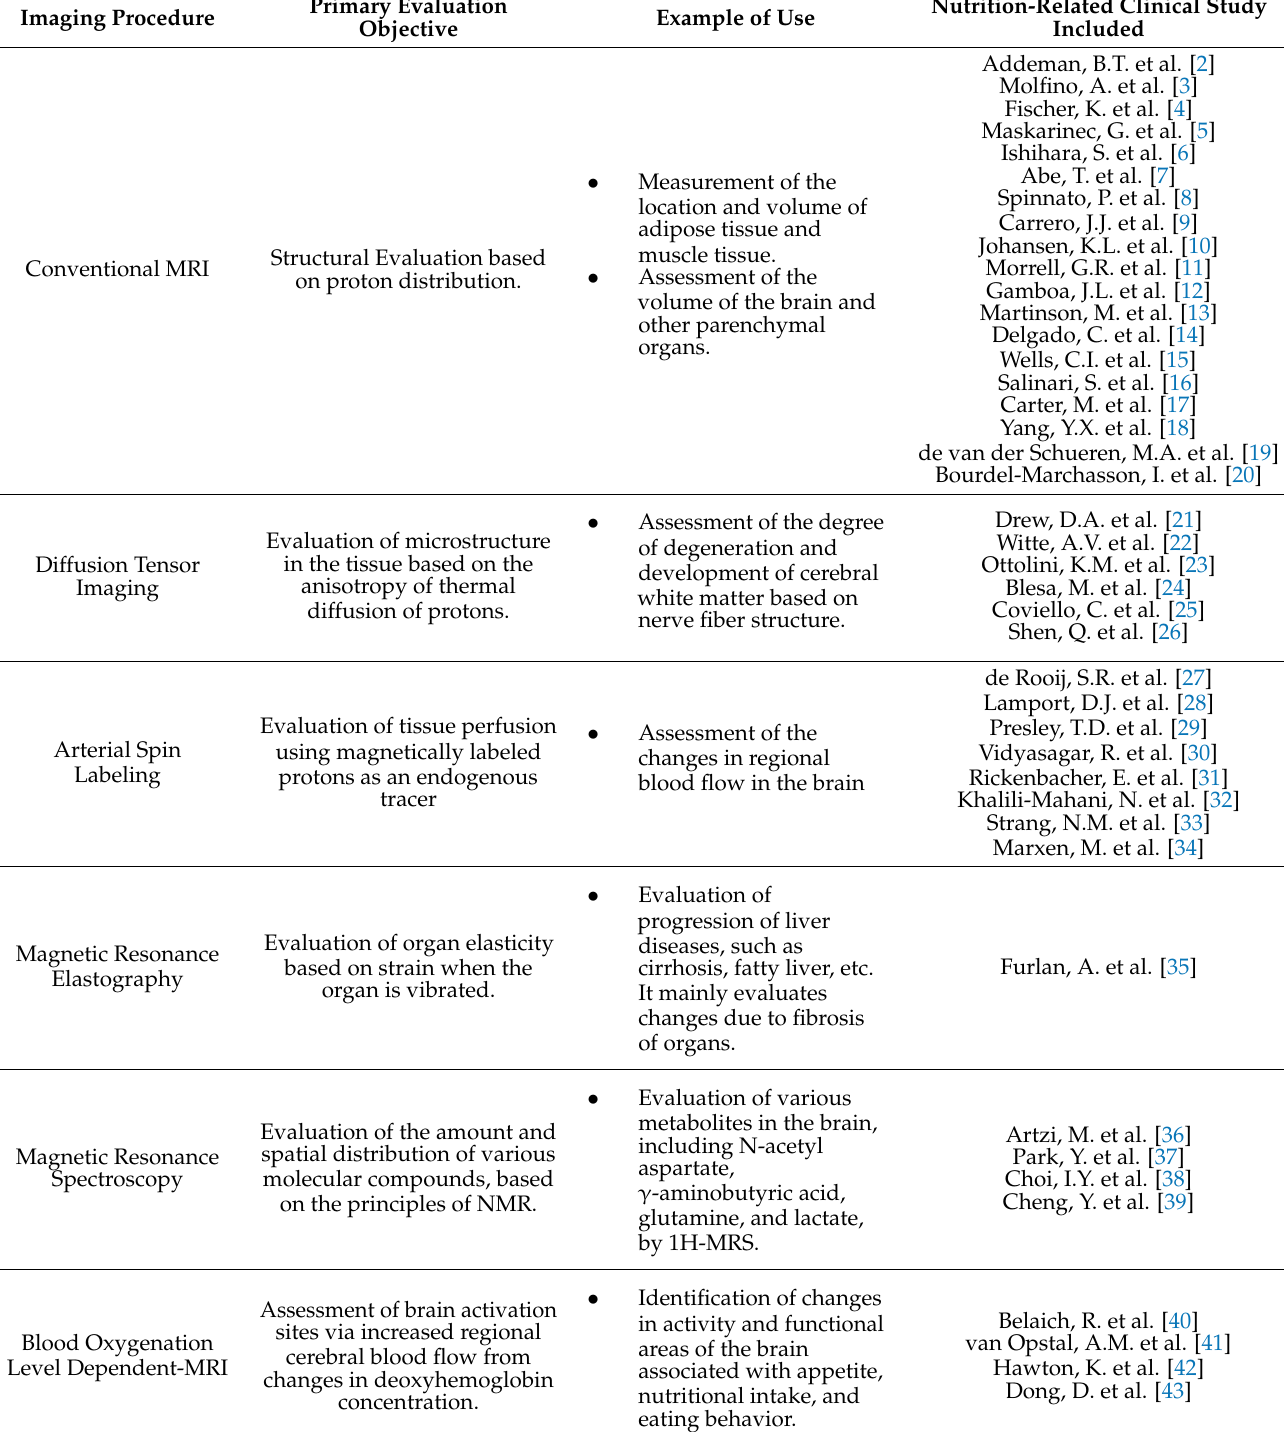
Table 1. A summary of the various MRI methods used in nutrition-related clinical studies reviewed in this article. Imaging